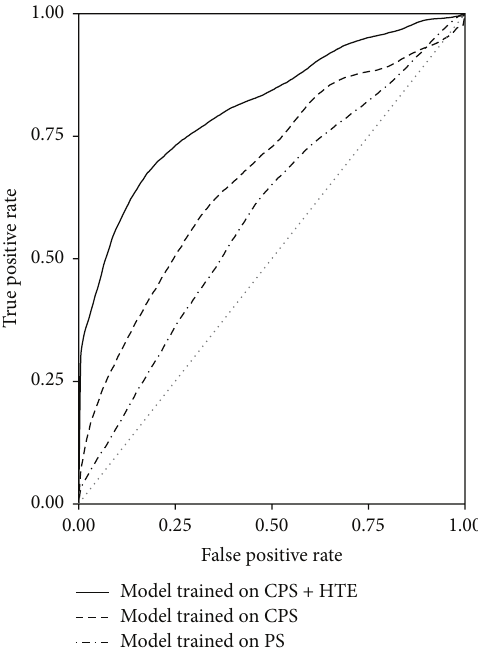
Figure 1: ROC curves for logistic regression models trained on dif- ferent features. CPS: conserved PPRE score; HTE: high throughput evidence; PS: PPRE